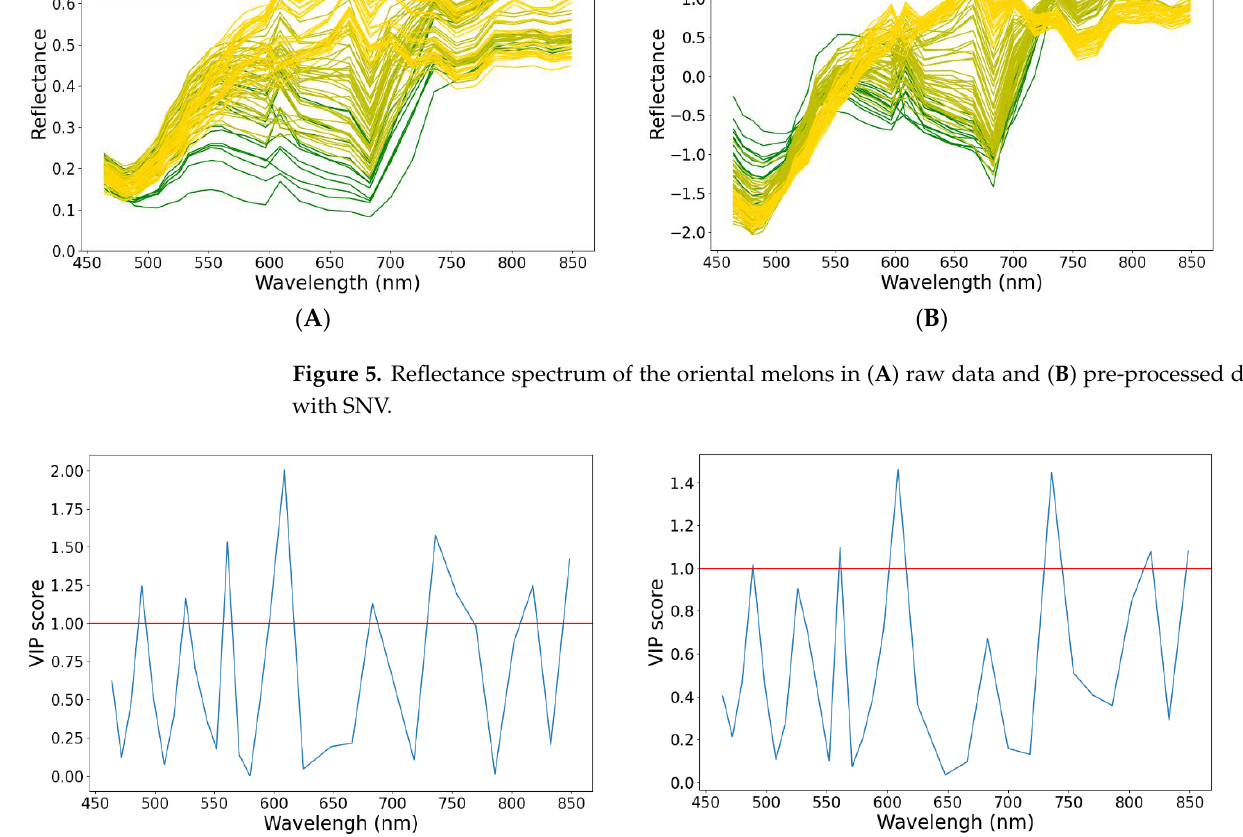
Figure 5. Reflectance spectrum of the oriental melons in ( A ) raw data and ( B ) pre-processed data with SNV.